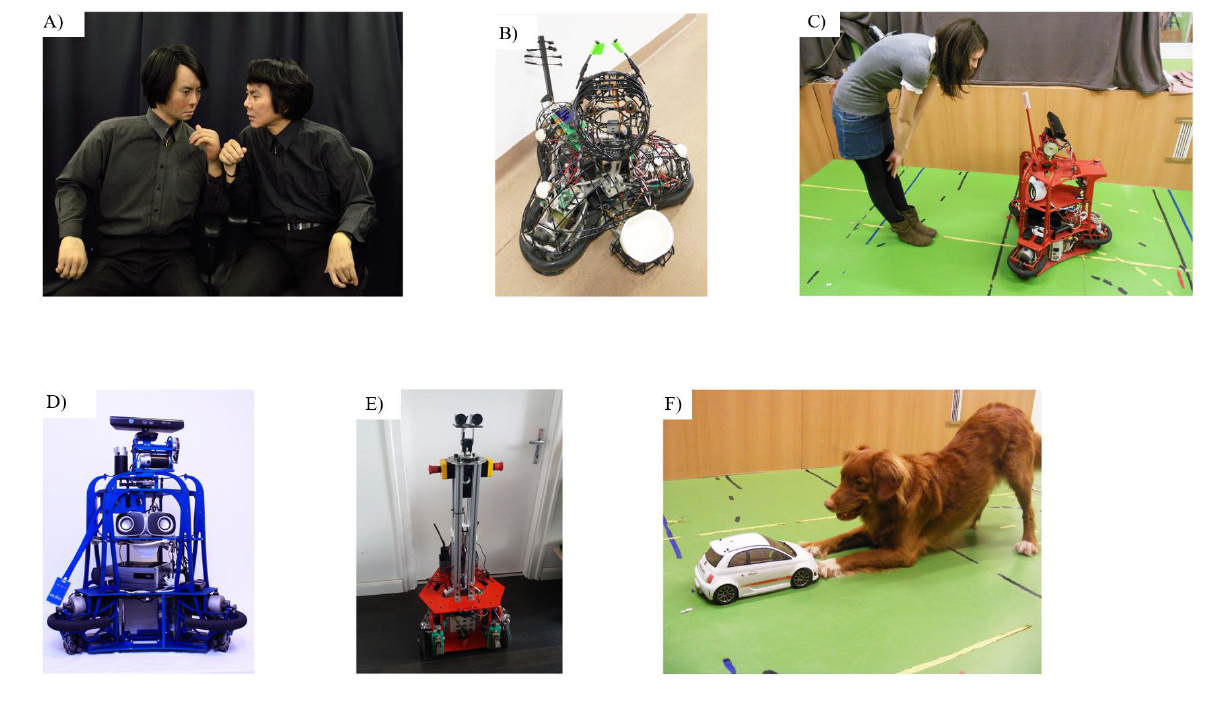
Figure 1 . Examples of the similarity of physical features between robots and the studied species. A ) the robot (on the left) is a perfect match to the studied species (Geminoid™ HI-2 has been developed by Hiroshi Ishiguro Laboratories, ATR); B ) the robot mimics only specific features of the studied species (MogiRobi ( Mogi caniformis ): Lakatos et al., 2014); C - F) the robot is completely different from the studied species ( C : Ethonis vulgaris rubrum (Tajti, Szayer, Kovács, & Korondi, 2014); D : Ethonis vulgaris caeruleus; E : Ethonis longicollis ; F : UMO (Abdai et al.,